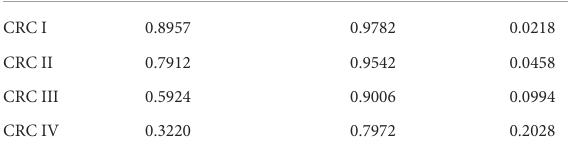
TABLE 2 Survival rates and mortality of the four CRC